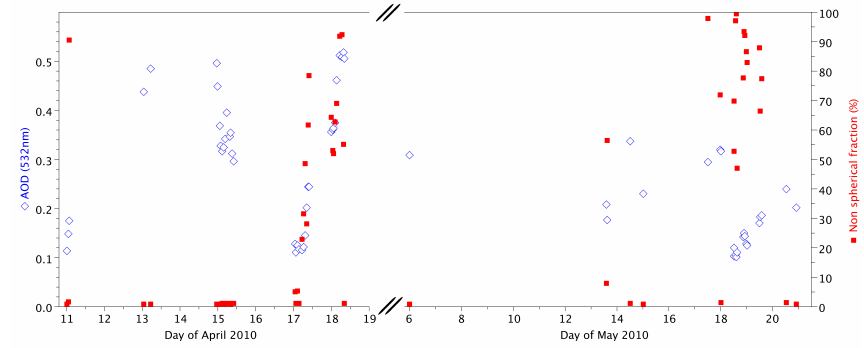
Fig. 1. Time series of AOD at 532nm (blue) and fraction in % (red squares) of non-spherical particles for April and May 2010 over Lille.